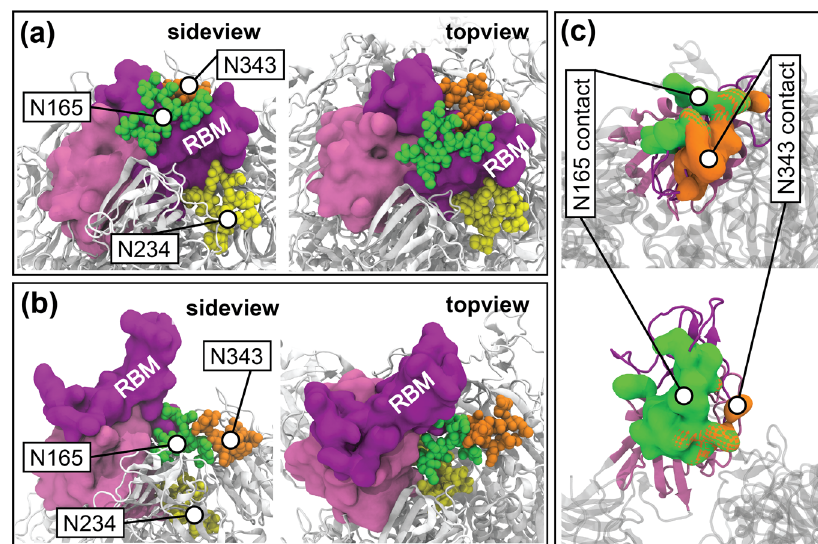
Fig. 5 Glycan-protein interactions. Representative locations of S-protein glycans at N165, N234, and N343 in S-protein a down and b up states extracted from the REUS trajectories. c Surface representation of RBD residues in (above) down and (below) up states that make contact with glycans at N165 (green) and N343 (orange). The cross-hatch pattern indicates contacts with both glycans. The up and down states of the S protein were selected from the